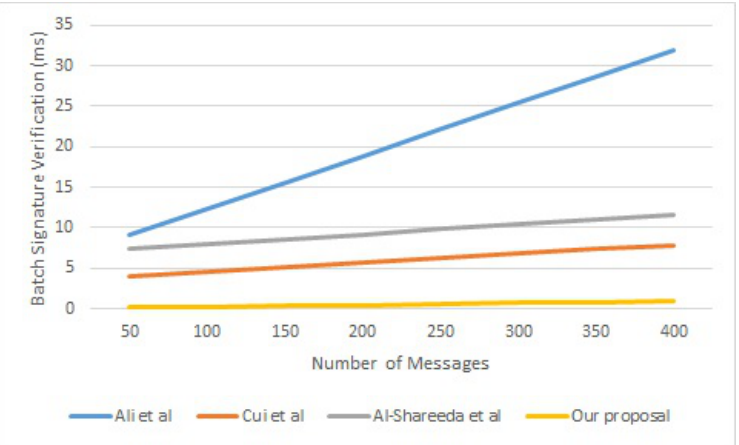
Figure 5. Computation cost of batch signature verification for authentication